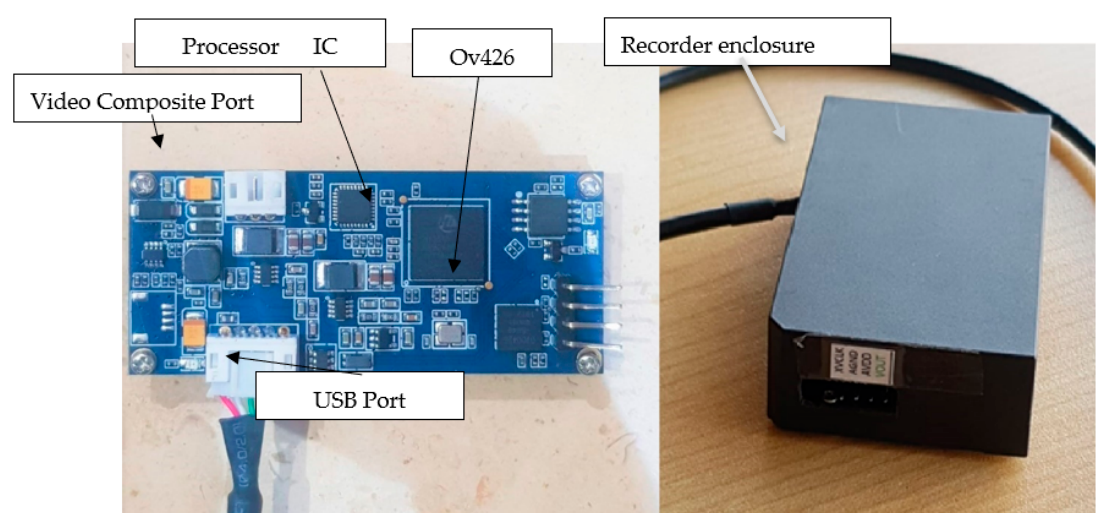
Figure 8. Recorder